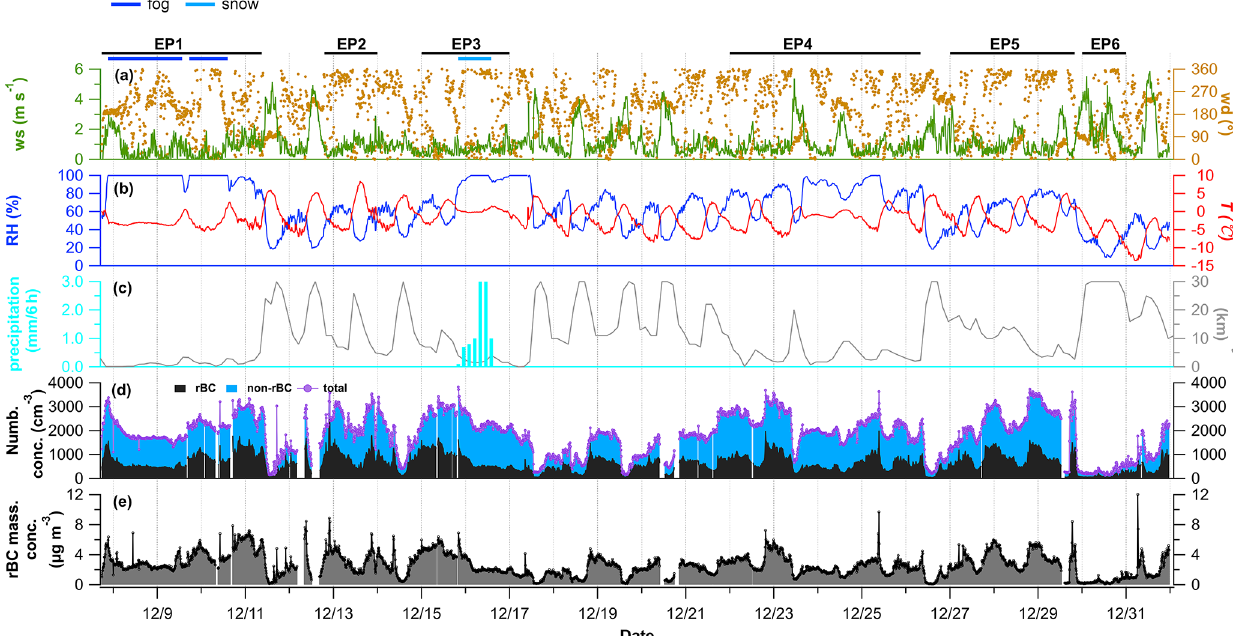
Figure 1. Time series of (a) wind speed (WS) and wind direction (WD), (b) relative humidity (RH) and ambient temperature ( T ), (c) precipitation and visibility, (d) number concentration of r BC-containing particles, purely scattering particles and total particles measured by the SP2 in GC, and (e) r BC mass